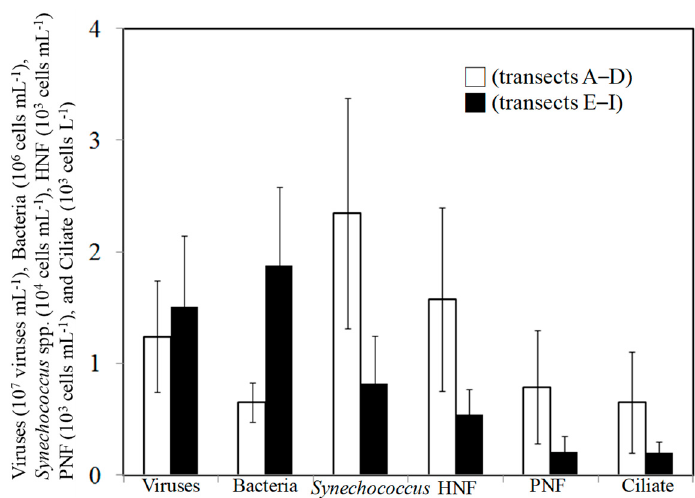
Figure 4. Mean values were determined from the transects A–D ( □ ) and transects E–I ( ■ ) for viral, bacterial, Synechococcus spp., HNF, PNF, and ciliate abundances.